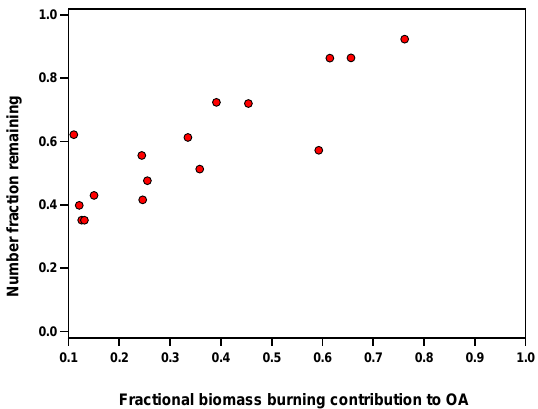
Figure 5. The number fraction remaining as a function of the frac- tional contribution of biomass burning to the organic aerosol mass. Each point corresponds to 0.5–1.2h.